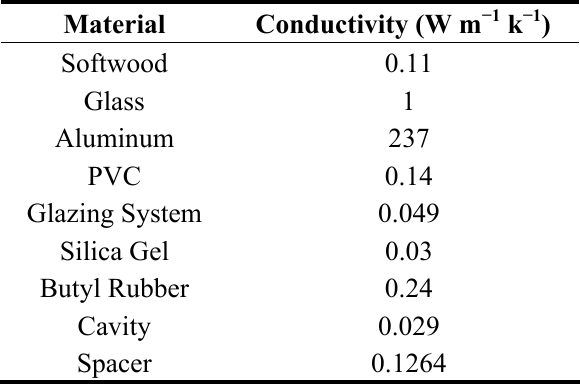
Table 1. Materials used for window frames, casement, and glazing systems and their